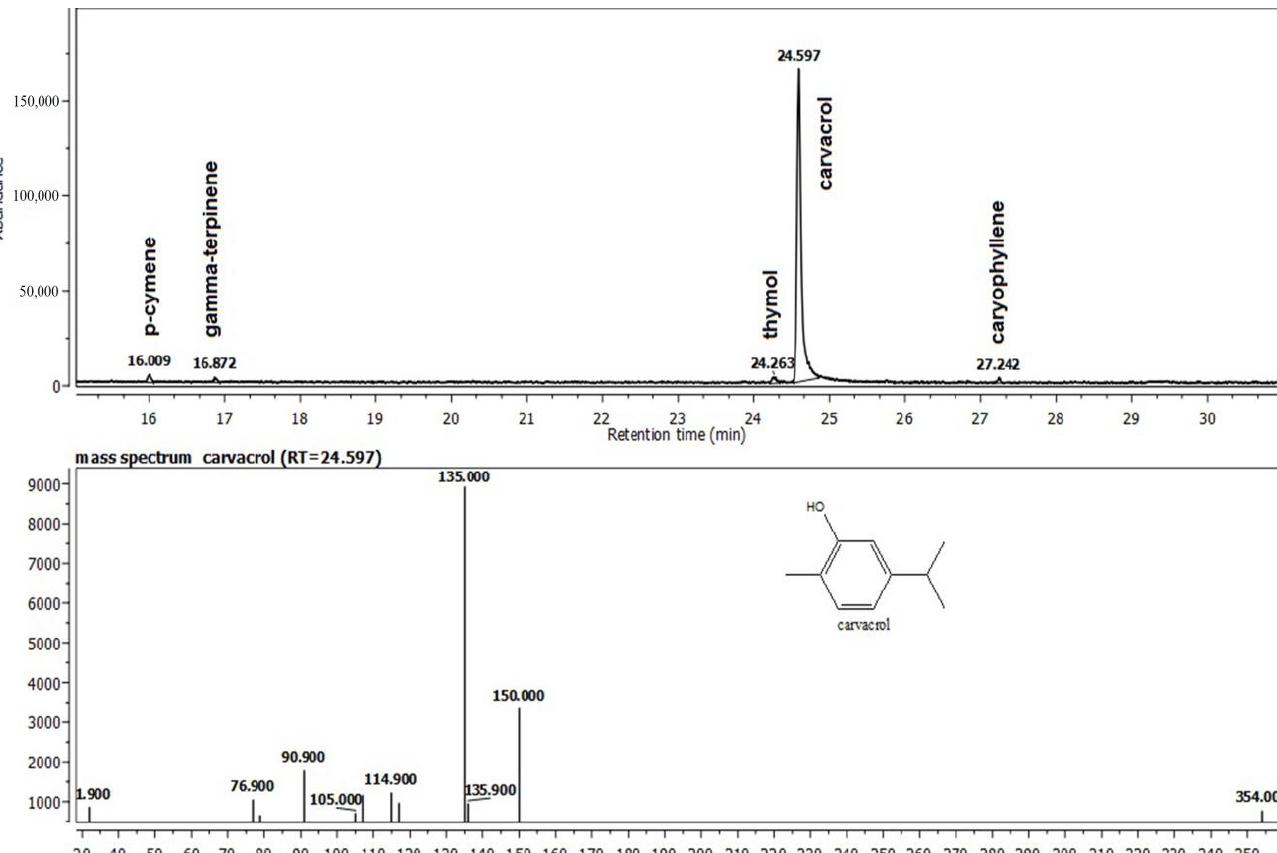
Figure 1. The composition of the Oregano ® oil (O) recovered from the gel G1O.